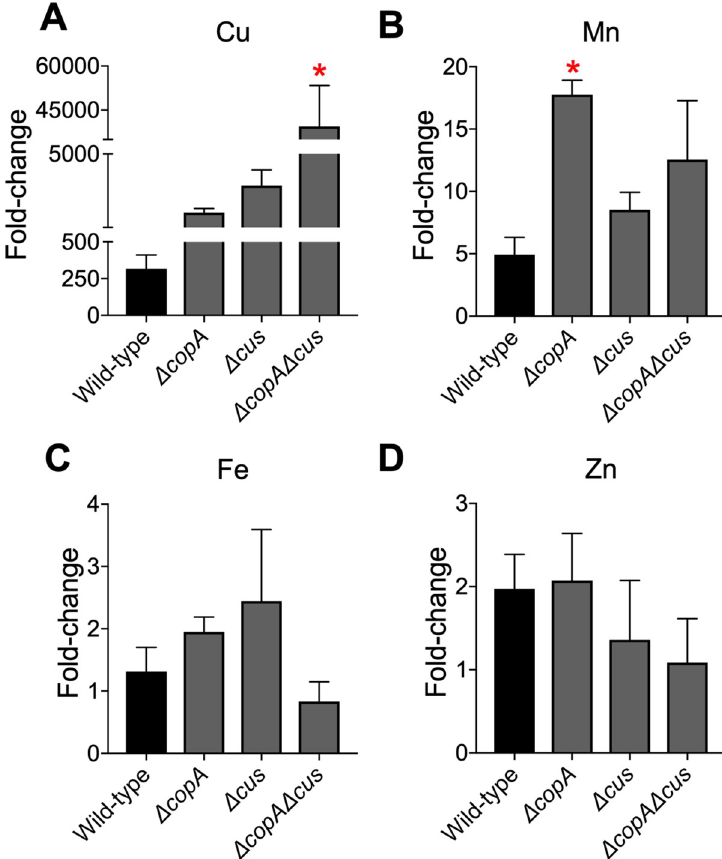
Fig 2. Increased copper content in UPEC cultured in copper-rich medium. Wild-type UPEC strain CFT073, and Δ copA , Δ cus , and Δ copA Δ cus mutants were grown in LB with or without copper to early logarithmic phase (OD 600 = 0.3). Cell-associated copper (A), manganese (B), iron (C), and zinc (D) levels were determined by ICP-MS, and normalized to viable cell count. Mean + SEM of fold-change in metal content, relative to controls, from 3 independent experiments is depicted. � P < 0 . 05 , ANOVA with Dunnett’s multiple comparisons